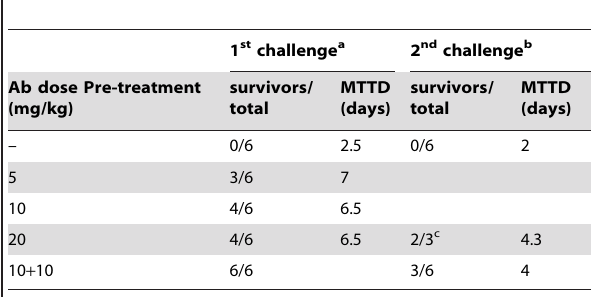
Table 3. Protection of Guinea pigs from anthrax infection by antibody